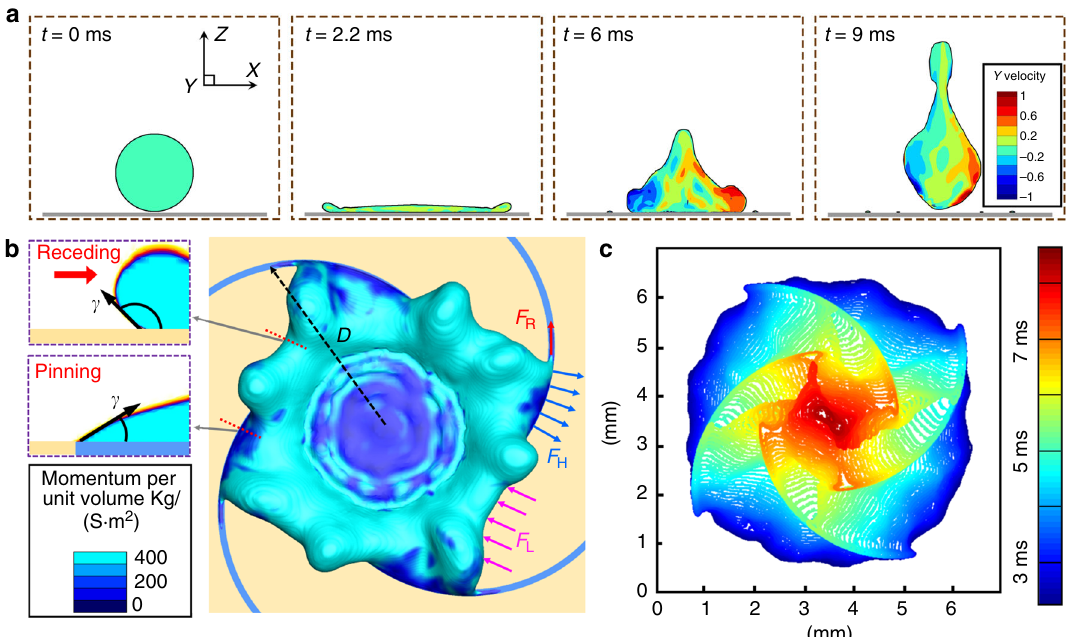
Fig. 2 Mechanical analysis of the droplet gyration. a Simulated results to show the out-of-plane velocity distribution in the cross-section of the droplet at typical stages of before contact ( t = 0 ms), maximum spreading ( t = 2.2 ms), receding ( t = 6 ms), and departing from the solid ( t = 9 ms). b Force model to analyze the origin of the droplet gyration motion. A symmetric unit is used for the analysis due to its symmetry. θ L and θ H are the contact angles of the liquid fi lm on the low-adhesive region and the high-adhesive spiral region, as shown by the simulated cross-sections. The driving forces from the solid to the liquid contain the force on the low-adhesive region ( F L , γ cos θ L per unit length, as marked by the pink arrows) and the force perpendicular to the high- adhesive spiral ( F H , γ cos θ H per unit length, as marked by the blue arrows). Meanwhile, the liquid fi lm remained on the high-adhesive spiral brings resistance to the droplet rotating ( F R , γ per unit length, as marked by the red arrows). D is the maximum spreading radius of the impacting droplet. The color shows the distribution of the momentum per unit volume. c Contours of the three-phase contact lines at different time of the retraction reveal that the liquid on the low-adhesive region recedes faster than that on high-adhesive spirals throughout the retraction